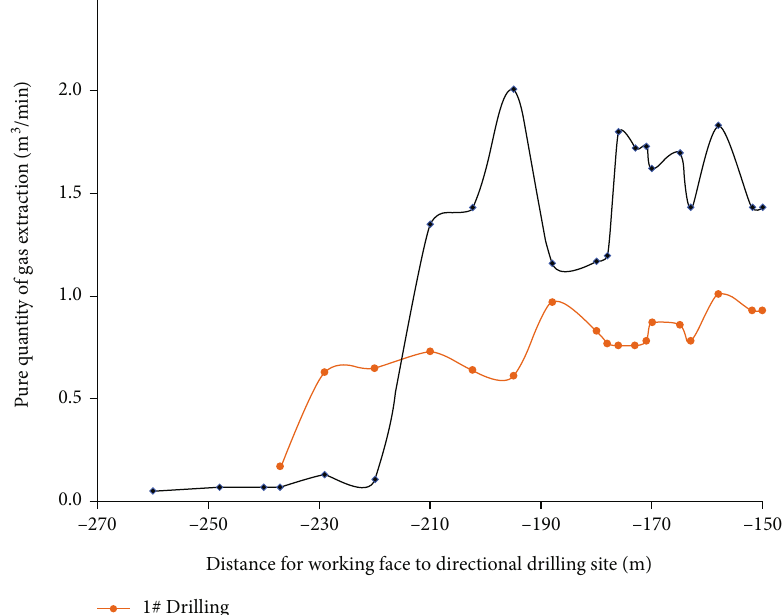
Figure 8: The relationship between the extraction parameters of the directional high-level drilling and the advancing step